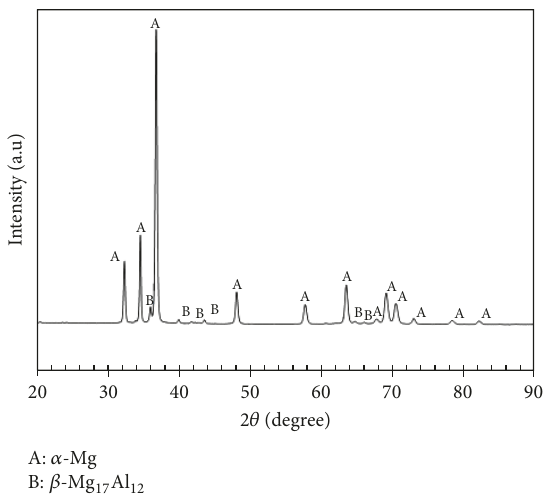
Figure 3: XRD pattern of the AZ91D magnesium